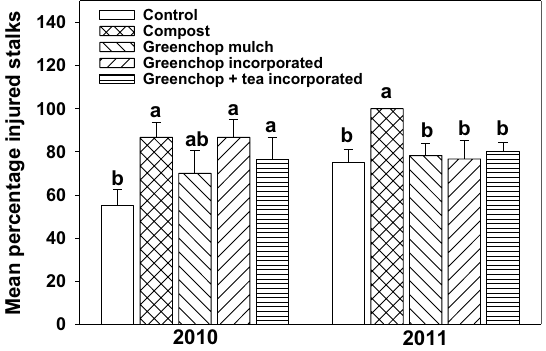
Fig. 3 Mean ( SE) percentages of sugarcane stalks injured by E. ± loftini tunneling field plots with soil amended with compost, and greenchop that was mulched, soil incorporated, and sprayed with compost extract before soil incorporation, and a non-amended control, ( n 6 plots), Hidalgo Co., Texas; 2010, =